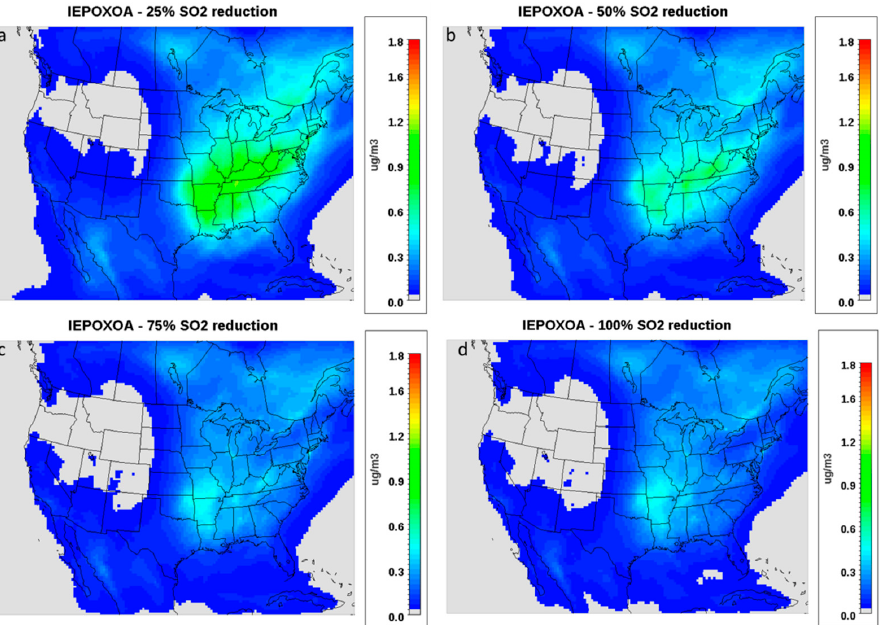
Figure 10. Simulated IEPOX OA fields over the CONUS for 25% ( a ), 50% ( b ), 75% ( c ) and 100% ( d ) SO 2 emission reductions.